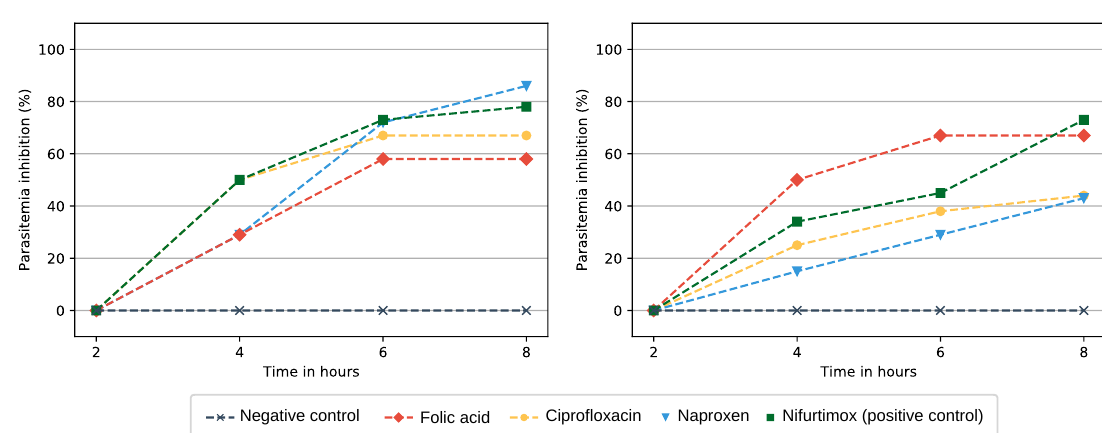
Figure 2. Parasitemia inhibition (%) of T. cruzi NINOA ( A ) and INC-5 ( B ) strains by the tested FDA-approved drugs during 8 h after administration. The plot shows parasitemia inhibition by the drugs ciprofloxacin (yellow line), naproxen (blue line), and folic acid (red line) at 2, 4, 6, and 8 h after administration. Drugs at a single dose of 100 mg/kg body weight were orally administered at day 13 post-infection when the infected mice reached an average parasitemia of 5 × 10 6 parasitemia/mL. Infected mice treated with nifurtimox (green line) and infected non-treated mice (gray line) were used as positive and negative controls,